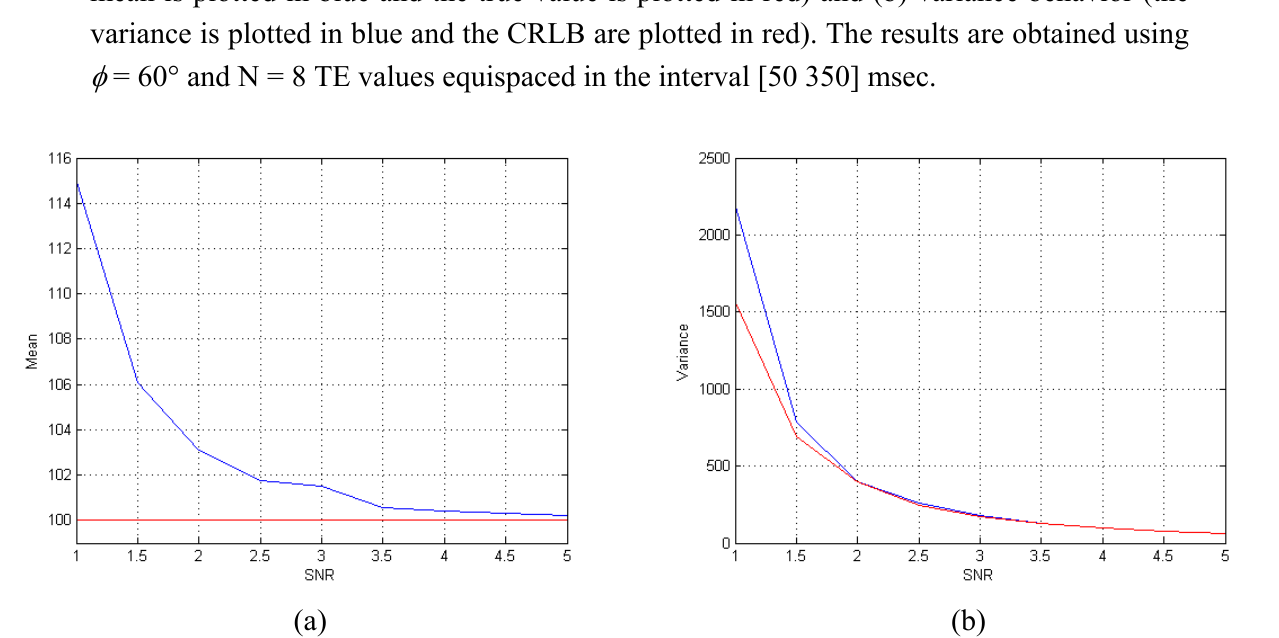
Figure 6. Performances of the T2 estimator for different SNRs. (a) Mean behavior (the mean is plotted in blue and the true value is plotted in red) and (b) variance behavior (the variance is plotted in blue and the CRLB are plotted in red). The results are obtained using